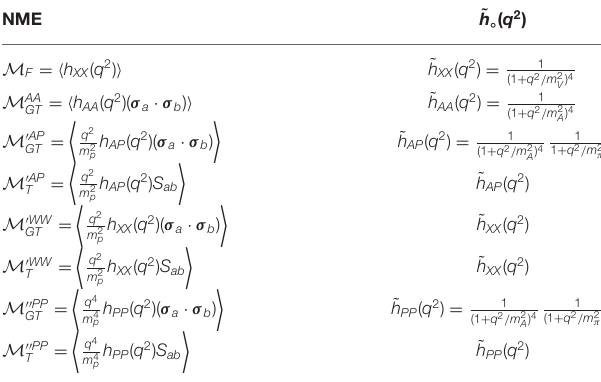
TABLE 1 | Double beta decay Fermi ( M F ), Gamow–Teller ( M GT ), and tensor ( M T ) NMEs appearing in Equation (12), with the associated reduced form factor product ˜ h ( q 2